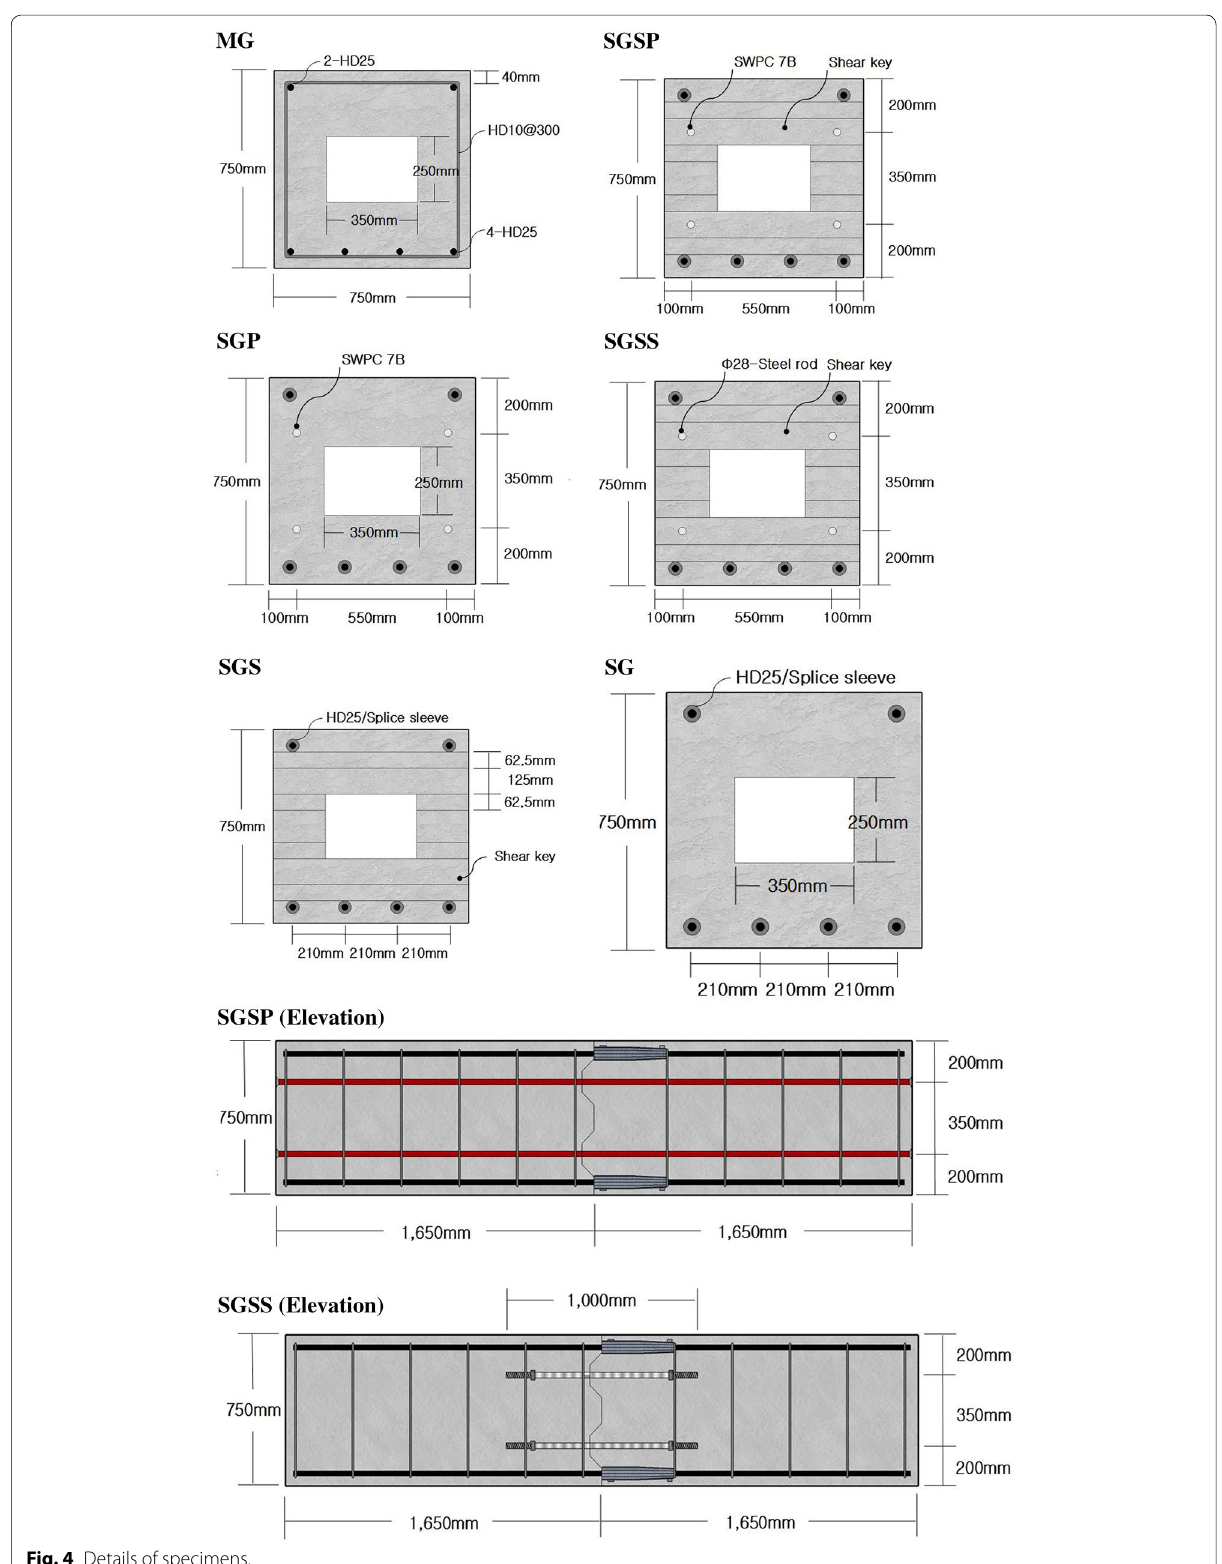
Fig. 4 Details of